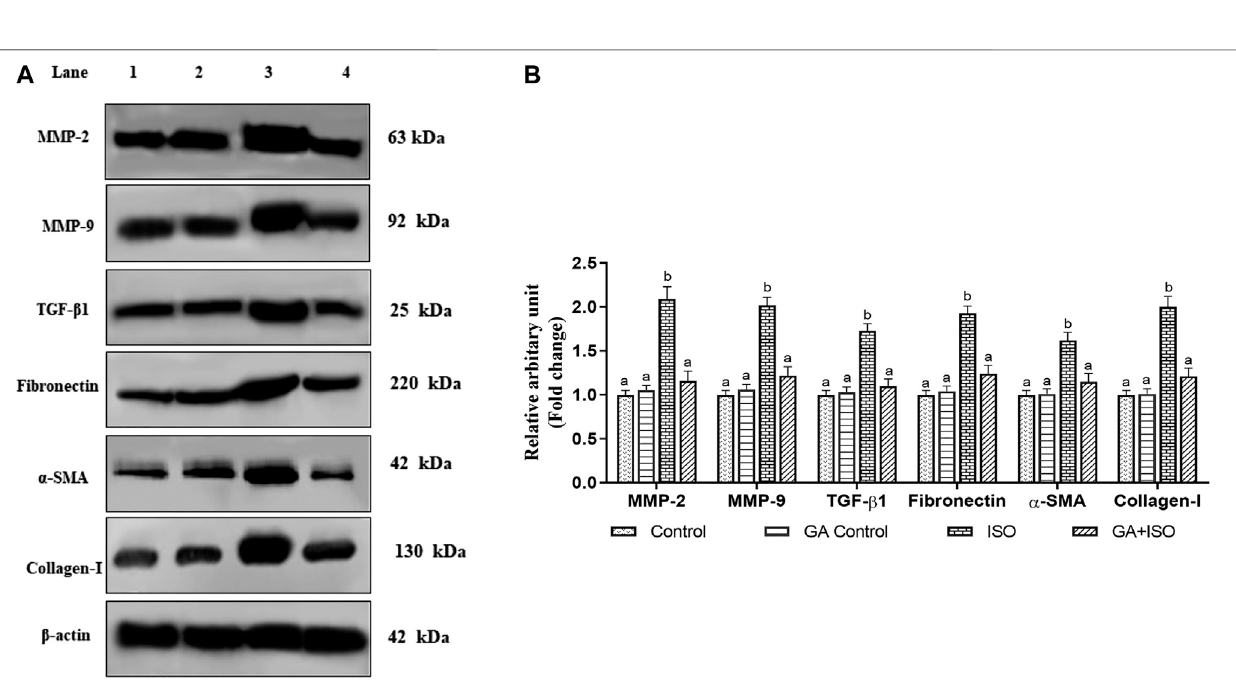
Frontiers in Pharmacology |